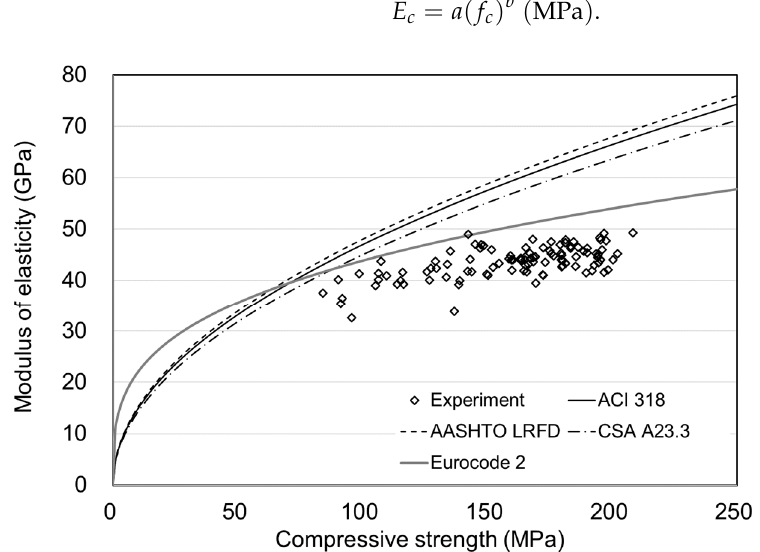
Figure 14. Compressive strength and MOE with the proposed equation for NSC.